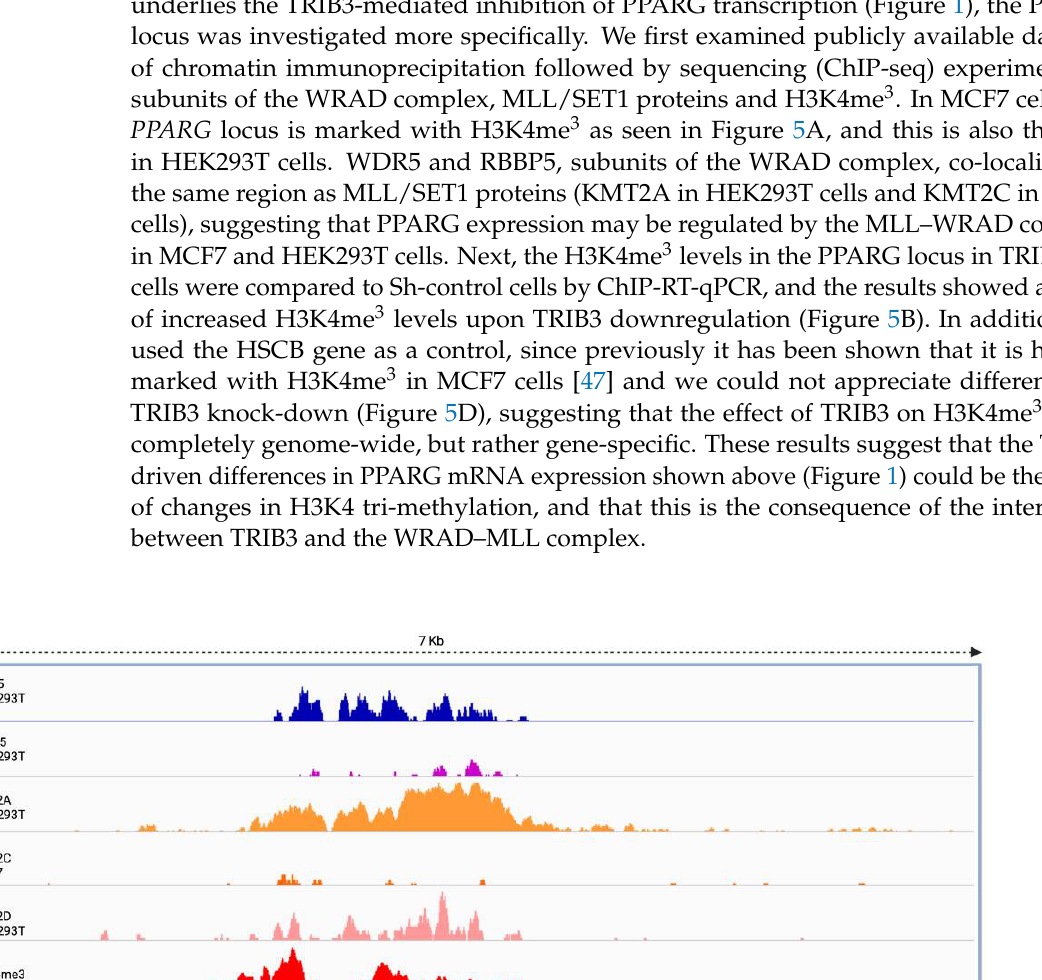
Figure 5. TRIB3 expression influences H3K4me 3 mark in the PPARG locus in MCF7 cells. ( A ) ChIP- seq data of WDR5 (GSM1493030), RBBP5 (GSM1037511), KMT2A (GSM2373702), KMT2D (GSM3444924) and H3K4me 3 (GSM3444908) in HEK293T cells as well as KMT2C (GSM3414777) and H3K4me 3 (GSM2813049) in MCF7 cells with 7 kilo-bases around PPARG locus shown. ( B ) ChIP-RT- qPCR of H3K4me 3 in Sh-TRIB3 and Sh-control cells in MCF7 using 2 different sets of primer pairs ( B , C ) designed around the PPARG transcription start site (TSS) shown in A. ( D ) ChIP-RT-qPCR of H3K4me 3 around TSS of HSCB gene. 2.5. TRIB3 Modulates PPARγ-Mediated Growth Inhibition in MCF7 Cells Our study situates TRIB3 as an epigenetic regulator that controls the expression of PPARG in breast cancer cells. To examine consequences on a cellular level, the effect of TRIB3 on PPARγ-mediated growth inhibition was examined, as the proliferation of MCF7 cells has been shown to be sensitive to rosiglitazone [48], a synthetic PPARγ agonist. We used an MTS assay to assess the proliferation capacity of cells treated with rosiglitazone (40 μM for 72 h). The downregulation of TRIB3 resulted in lower proliferation compared to control cells (Figure 6A). In addition, the induction of TRIB3-tGFP in MCF7 cells showed an increased proliferation rate compared to the uninduced cells (Figure 6A). Taken together, our data suggest that TRIB3 modulates PPARγ-mediated growth inhibi- tion by interfering with the MLL complex in MCF7 breast cancer cells. A schematic repre- sentation of our model can be found on Figure 6B.